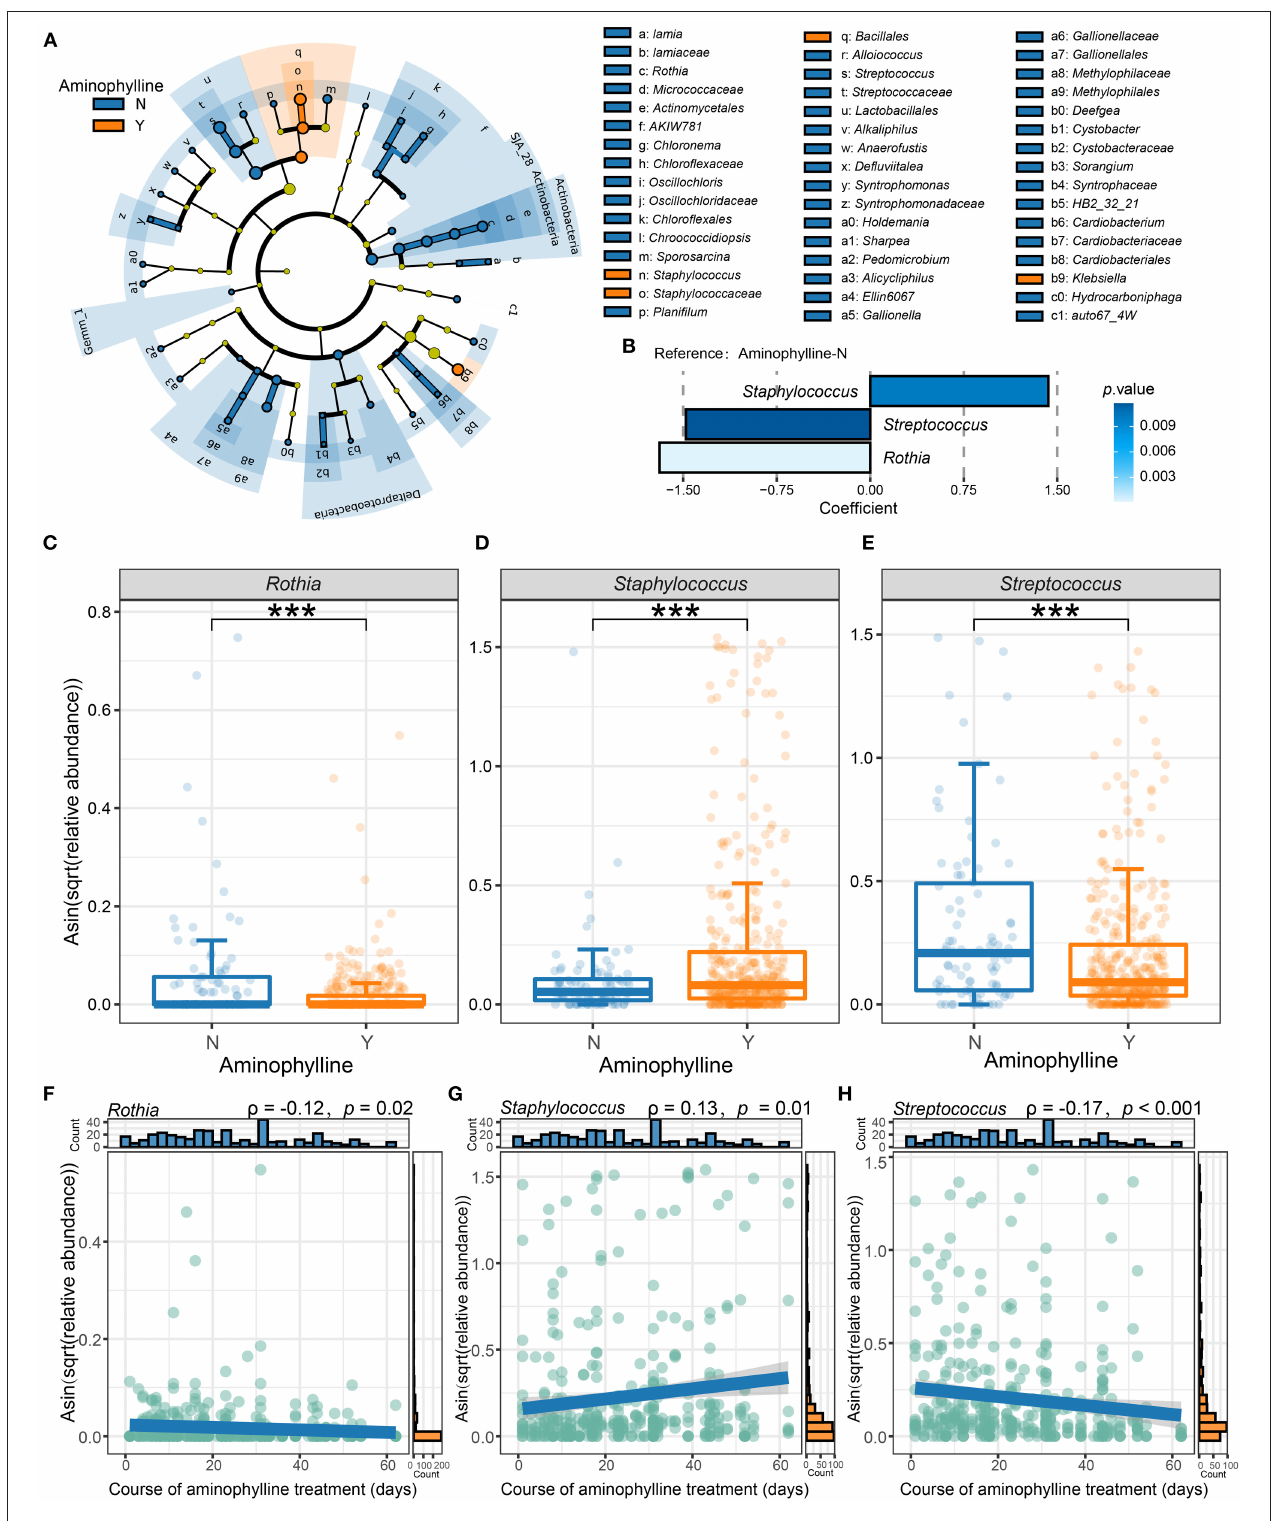
FIGURE 4 | Differences in the microbiome between the aminophylline-treated group and the control group. (A) A cladogram of the LEfSe analysis shows the significantly differentially abundant bacteria between the group that received aminophylline and the group that did not. Taxonomic levels are represented by rings